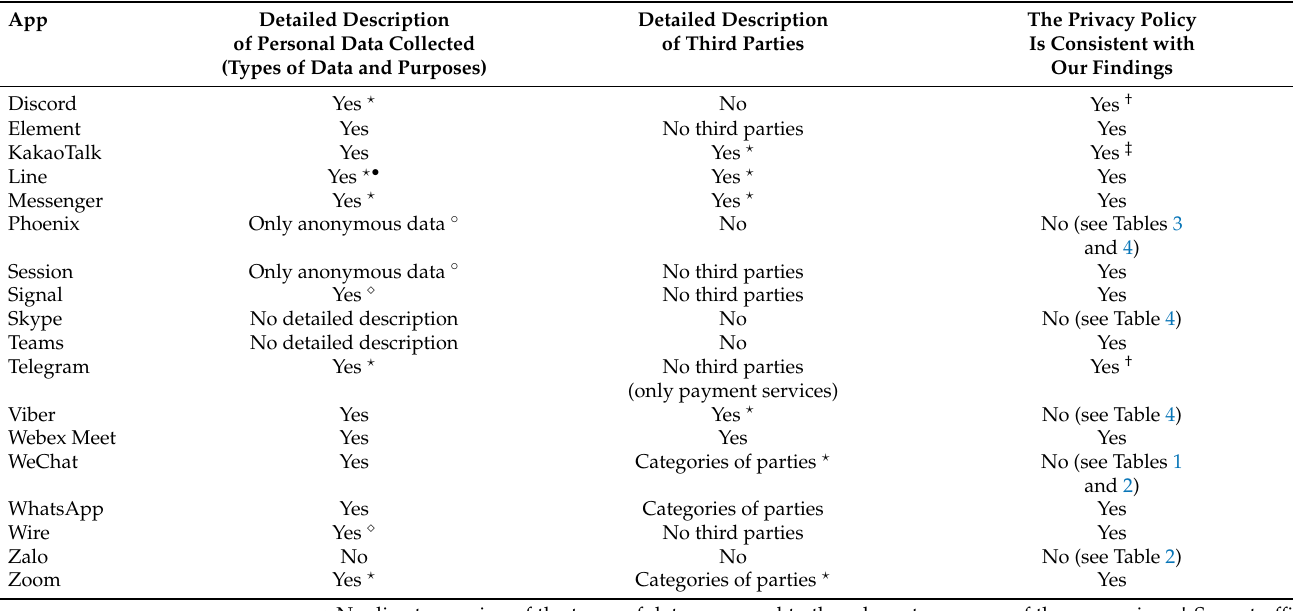
Table 5. Summary of the examination of the privacy policies of the